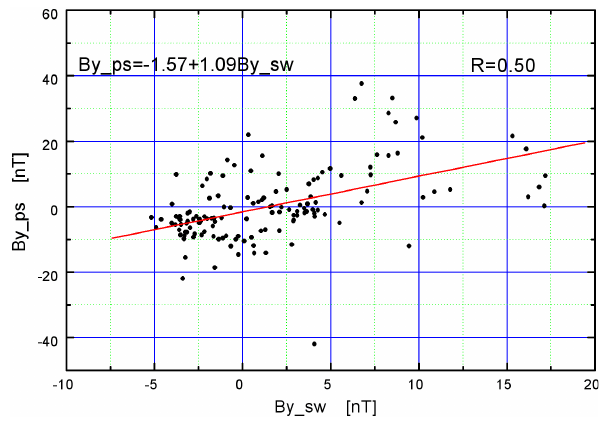
Fig. 1. The relationship between B y in solar wind and that in plasma sheet in GSM